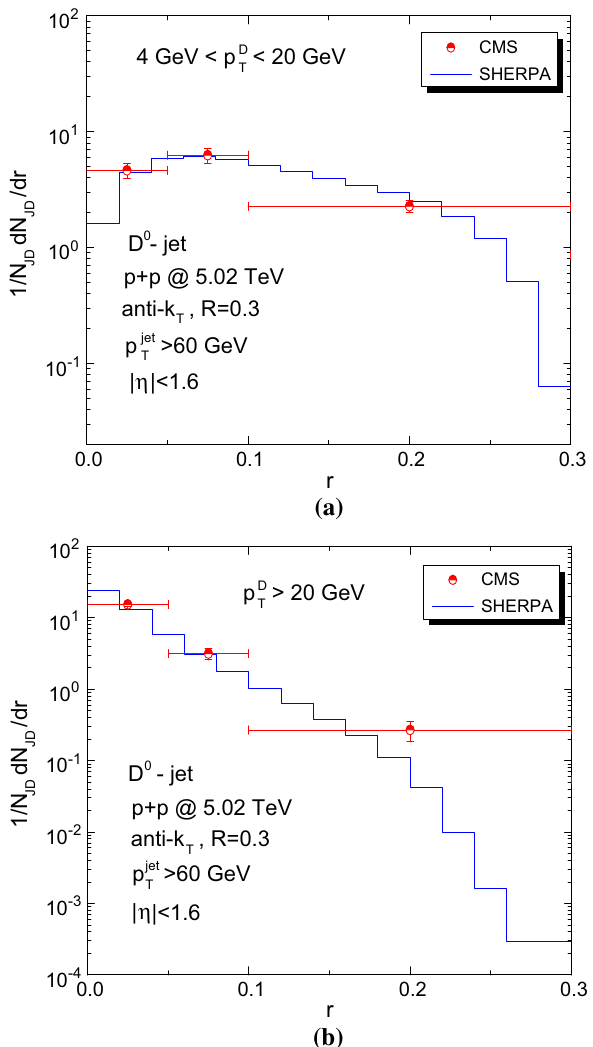
Fig. 1 The normalized radial distributions of D 0 meson in jets as a function of the angular distance from the jet axis in p + p collisions at 5 . 02 TeV provided by SHERPA are compared with CMS data. The jets are selected at | η jet | < 1 . 6 and with transverse momentum p jet 60 GeV, the proposed p T constrain for D 0 meson are a 4 GeV < p T < 20 GeV and b p T > 20 GeV